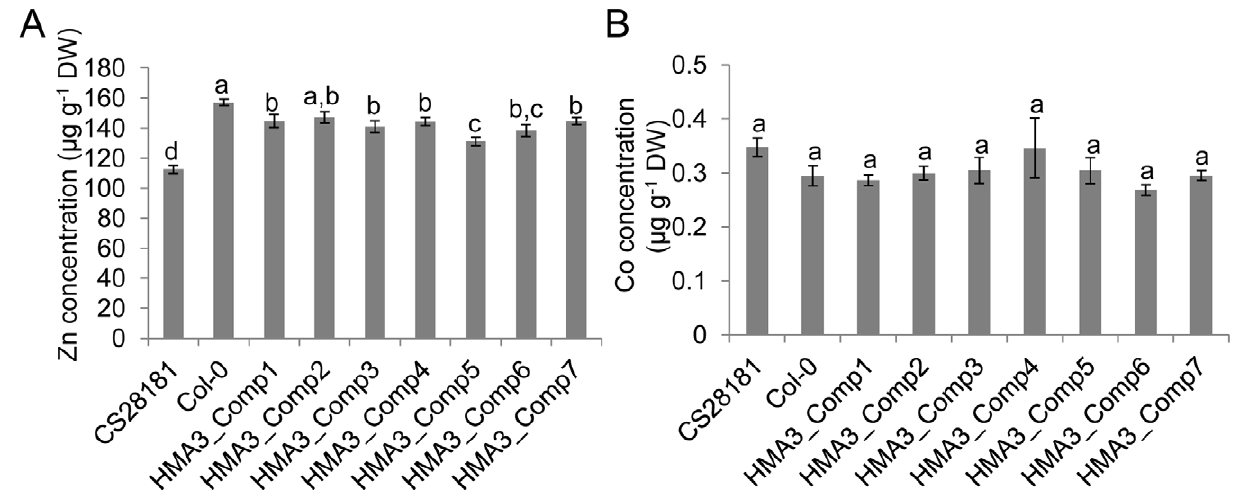
Figure 8. The effect of HMA3 function on A.thaliana leaf Zn and Co. The A. thaliana Col-0 accession was transformed with CS28181 HMA3 and leaf Zn (A) and Co (B) concentration determined. Transgenic lines were made by introducing the CS28181 genomic DNA fragment of HMA3 (including promoter sequence) into the Col-0 accession. Data represents the mean leaf Zn and Co concentrations 6 standard errors (n=7–12 independent plants per genotype). Letters above bars indicate statistically significant groups using a one-way ANOVA with groupings by Tukey’s HSD using a 95% confidence interval.